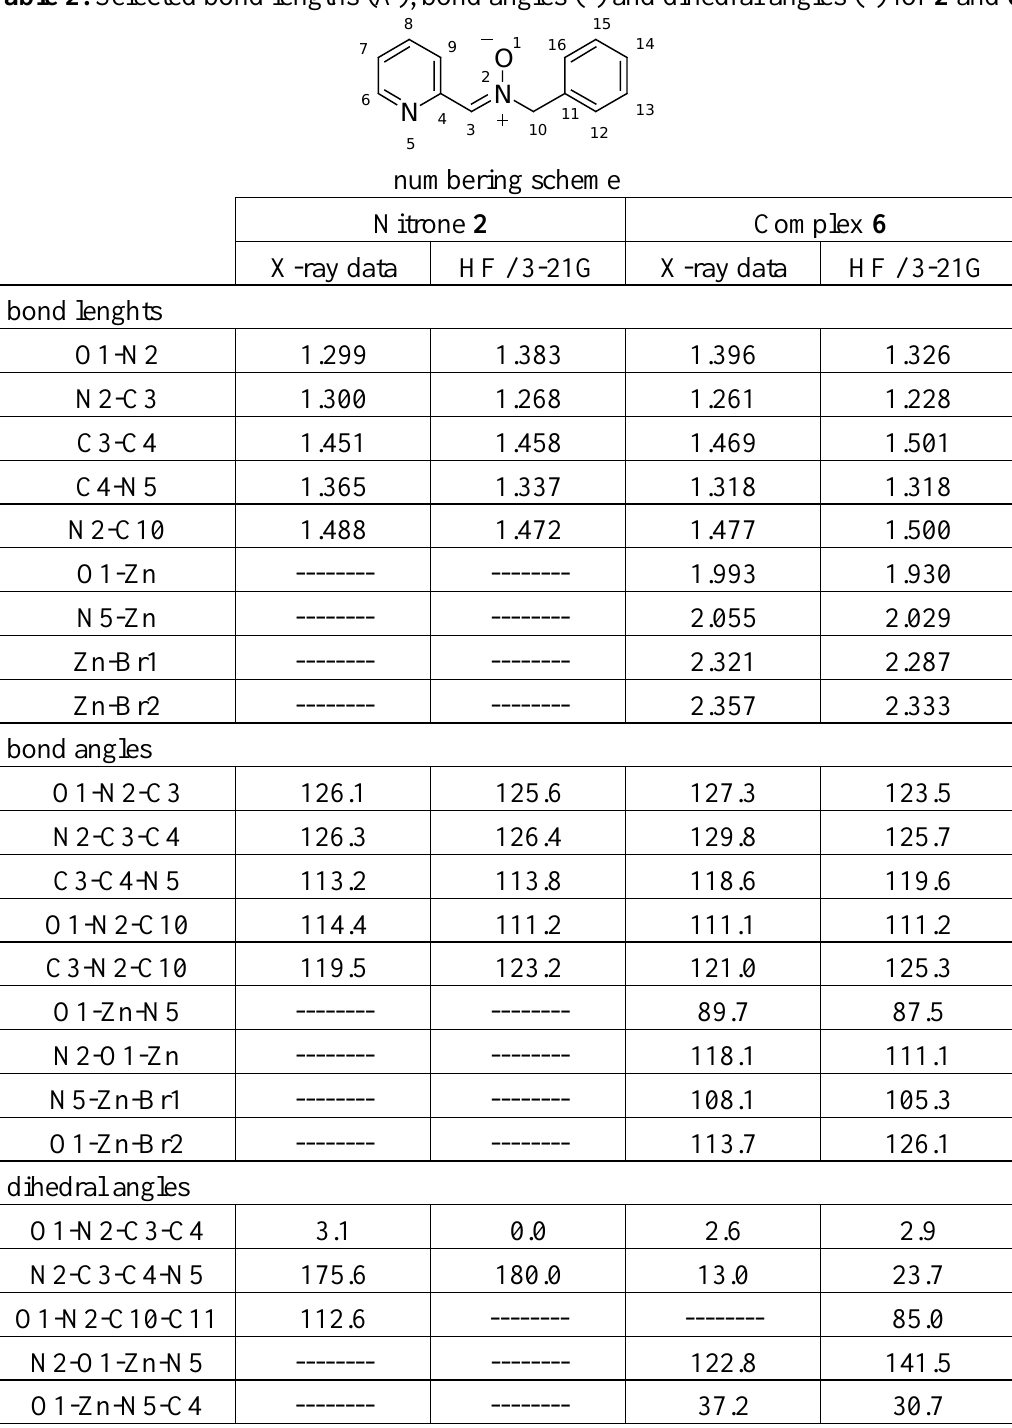
Table 2. Selected bond lengths (Å), bond angles (°) and dihedral angles (°) for 2 and 6 .